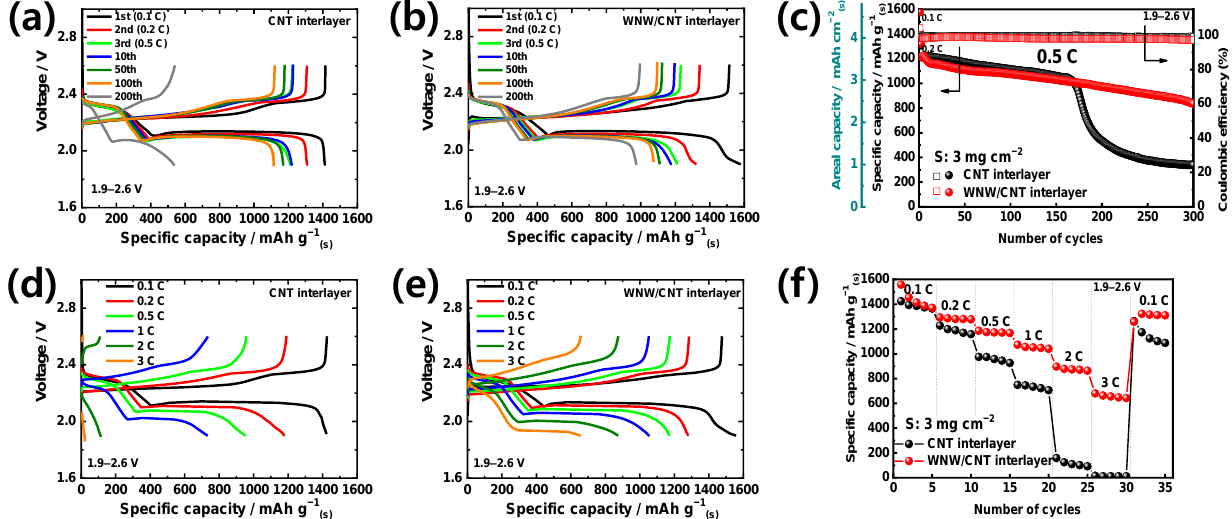
Figure 5. Voltage profiles of the lithium-sulfur cells, at 0.5 C, containing ( a ) CNT interlayer and ( b ) WNW/CNT interlayer, respectively. ( c ) Cycling performance of the lithium-sulfur cells. Voltage profiles of the lithium-sulfur cells, at different current densities, containing a ( d ) CNT interlayer and a ( e ) WNW/CNT interlayer, respectively. ( f ) Rate capability of the lithium-sulfur cells. The sulfur loading of all cells is 3 mg cm − 2 .